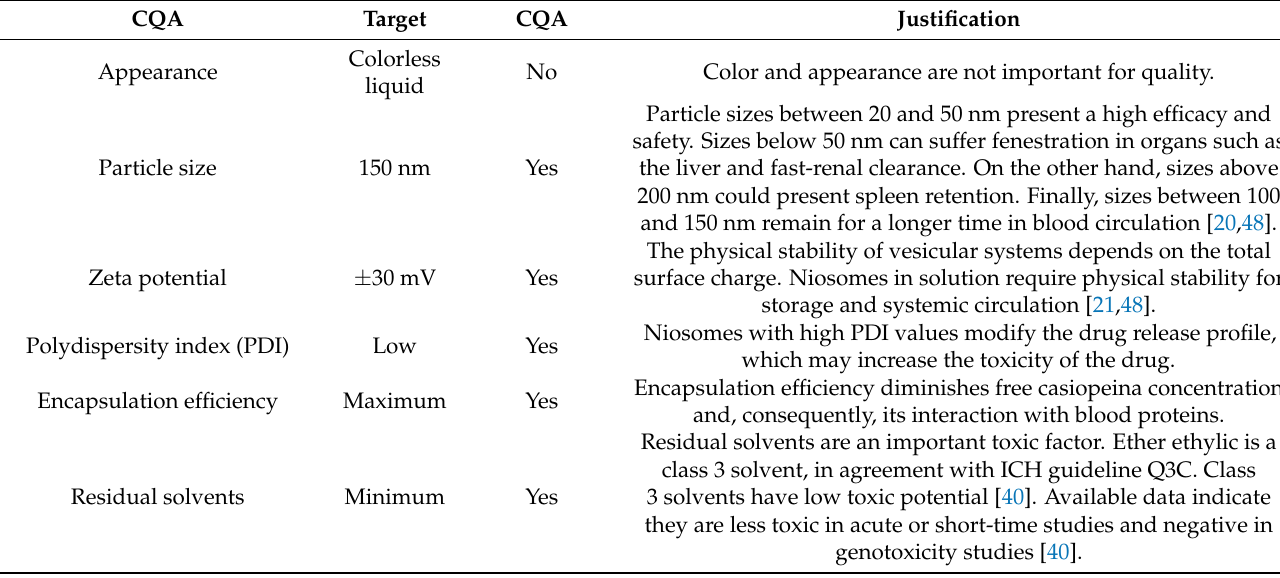
Table 6. Critical quality attributes for CasIII-ia